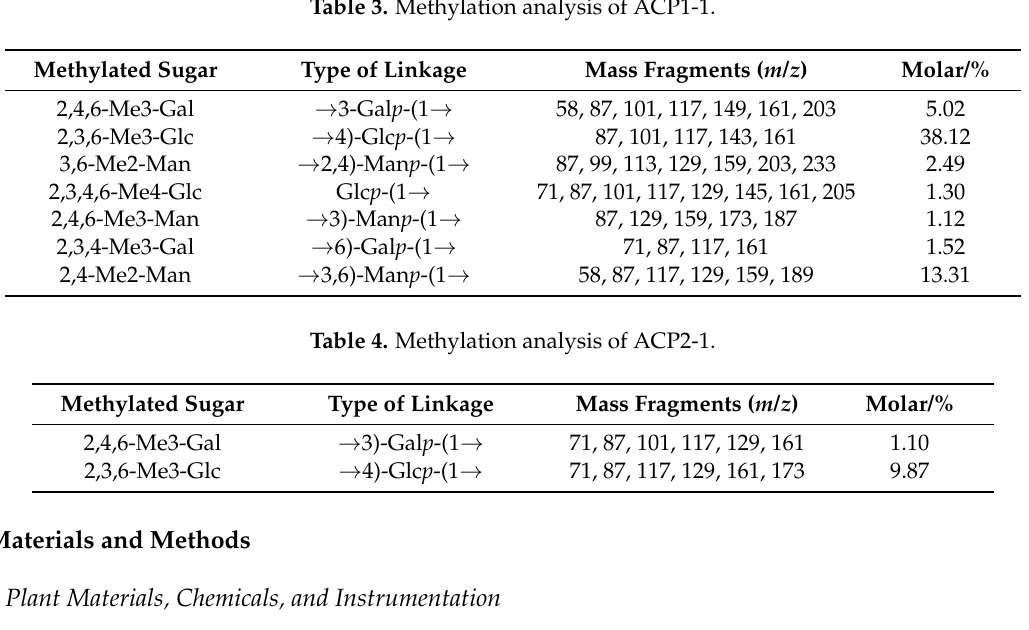
Table 3. Methylation analysis of ACP1-1.